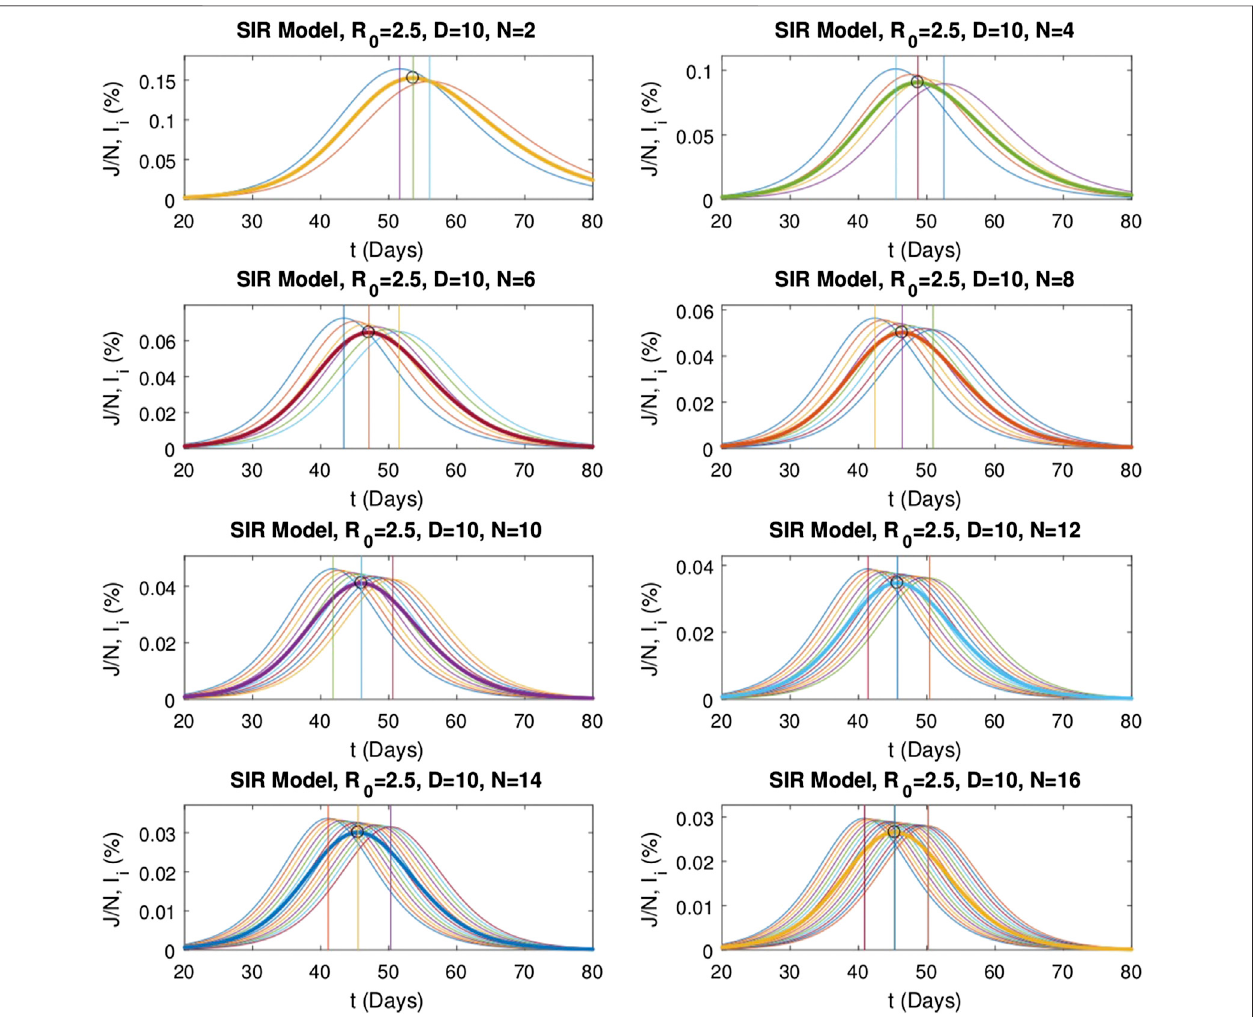
FIGURE 9 | Change of the position of maximum of J / N (normalized J ) in time with respect to the number of stages N for the multistage SIR model. “ o ” indicates the position of the maxima of J / N (thick curves). Vertical lines represent the position of maximum points of the fi rst stage, J / N , and the last stage,